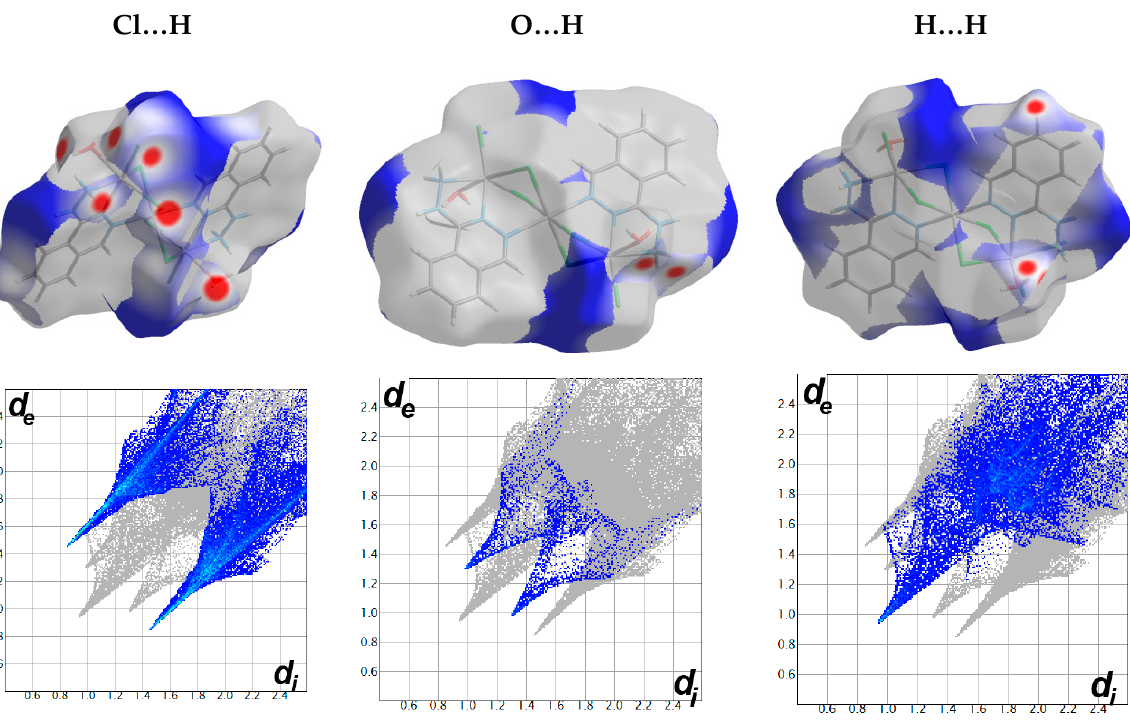
Figure 14. The decomposed fingerprint plots ( lower ) and d norm maps ( upper ) of the most important contacts in complex 3 .